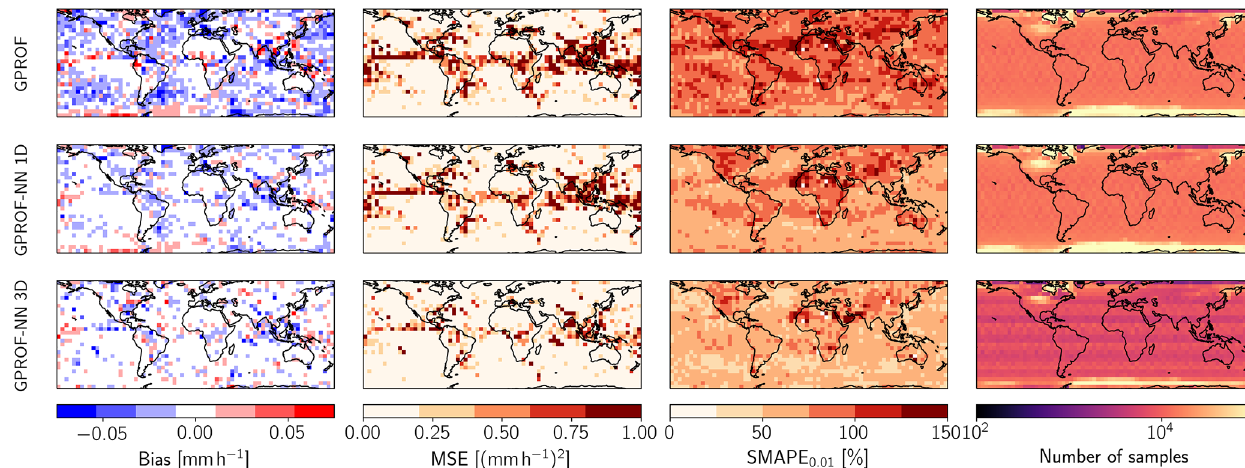
Figure 8. Spatial distributions of bias (column 1), MSE (column 2), SMAPE 0 . 01 (column 3), and the counts in each 5 ◦ × 5 ◦ box (column 4) for the GPROF (row 1), GPROF-NN 1D (row 2), GPROF-NN 3D (row 3) algorithms for